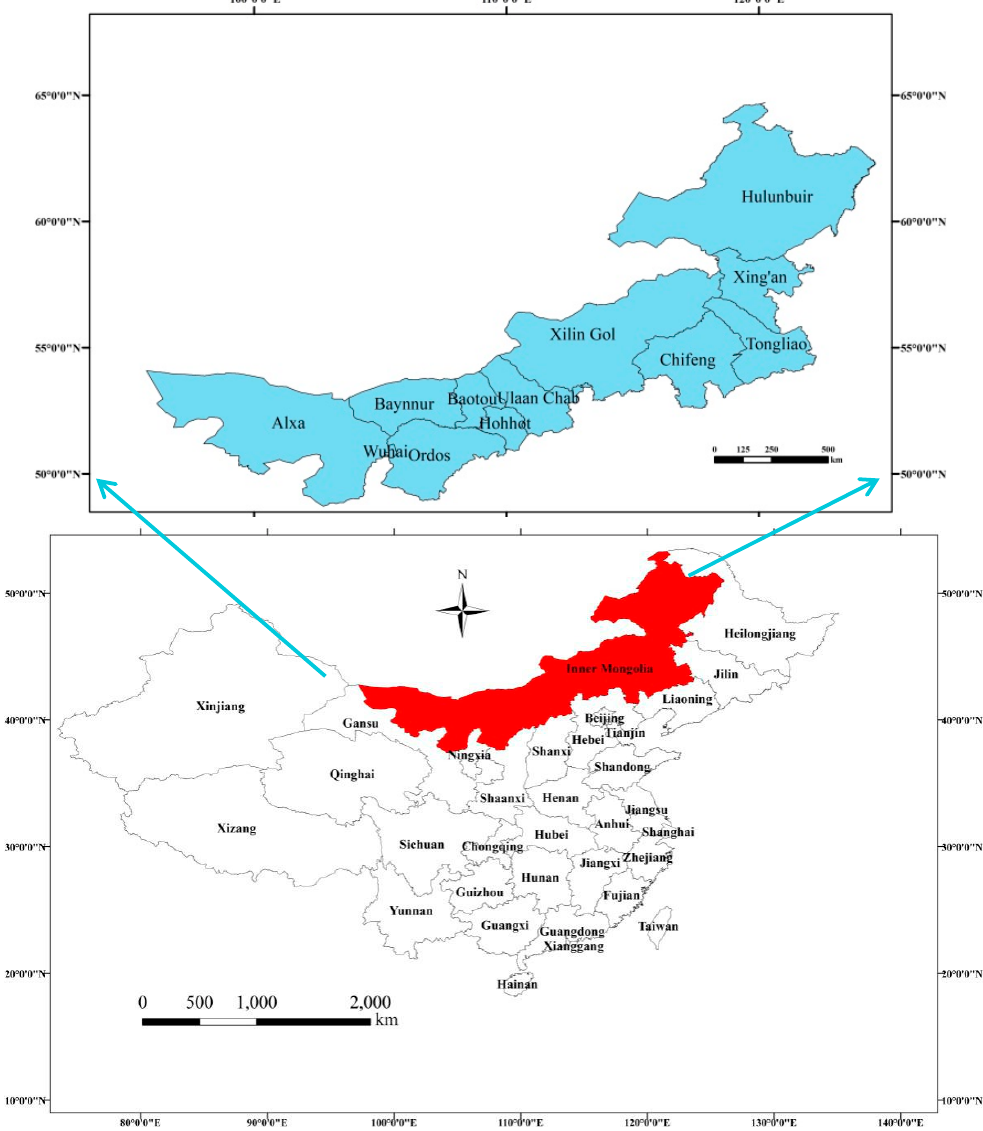
Figure 1. Geographical position and districts of Inner Mongolia, China.